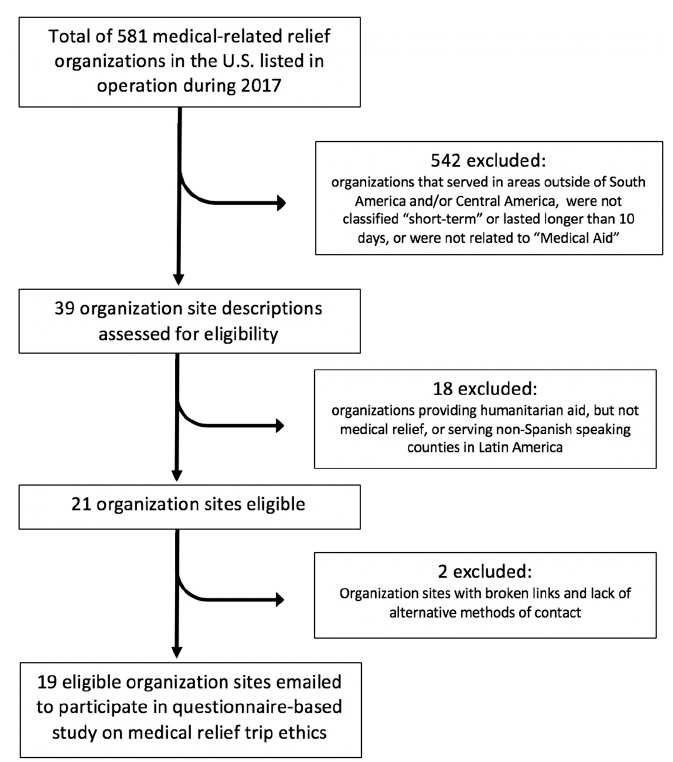
Figure 2. Exclusion and selection process for eligible medical relief organizations included in this research study.